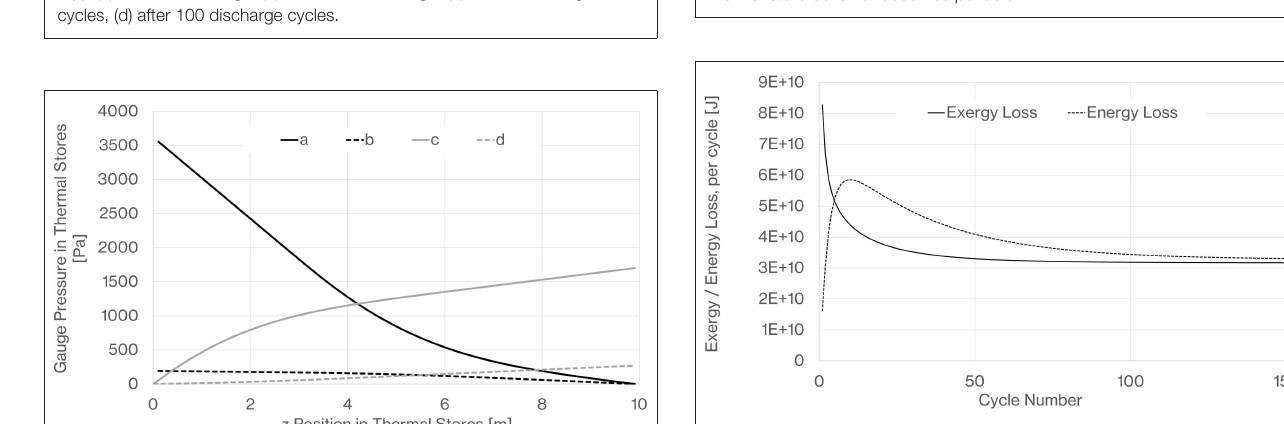
FIGURE 17 | Stabilization of exergy within thermal stores indicating that thermal store behavior becomes periodic.